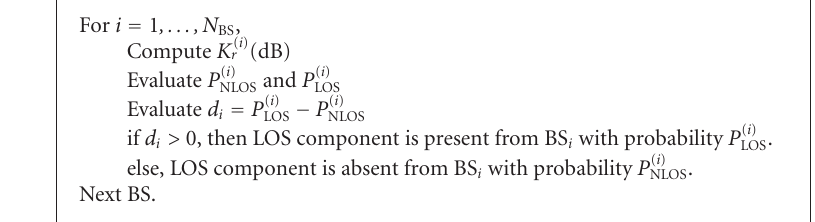
Algorithm 1: Rician factor-based LOS detection.